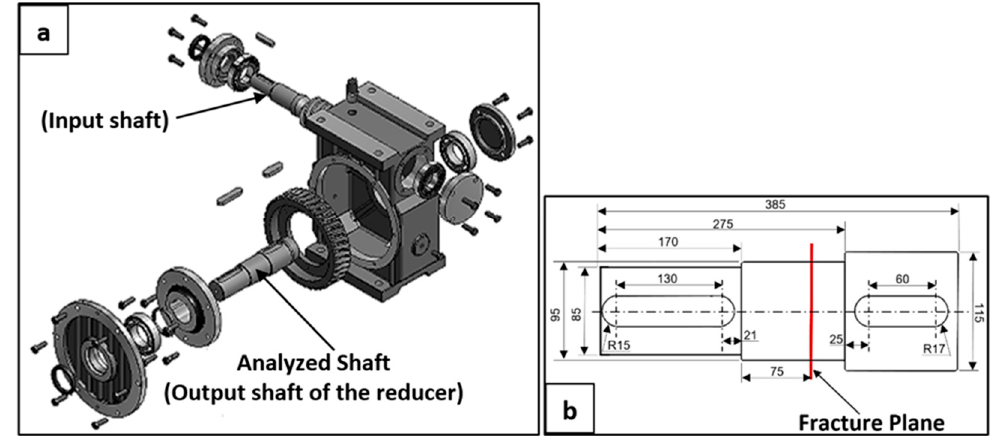
Figure 1. ( a ) Reduction box system, indicating the analyzed shaft; ( b ) dimensions in millimeters of the fractured output shaft and location of the fracture plane.